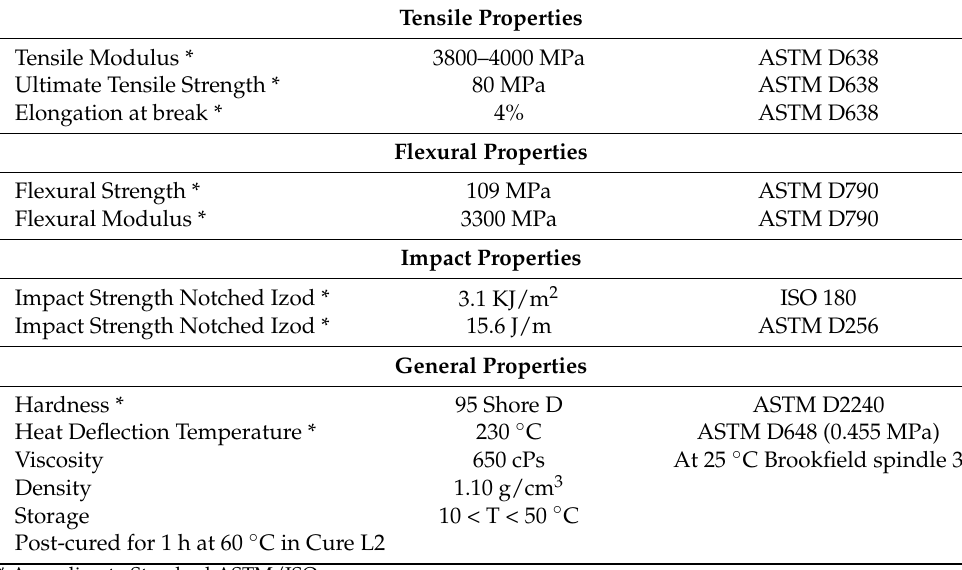
Table 2. Mechanical properties of the HighTemp DL400 resin [18].